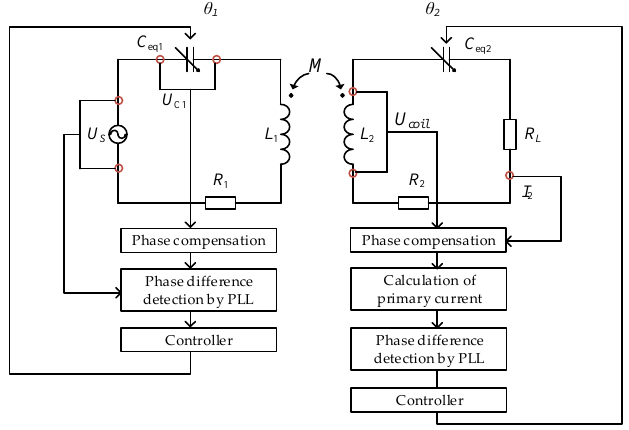
Figure 9. Scheme of the dual-side switched capacitor control strategy.